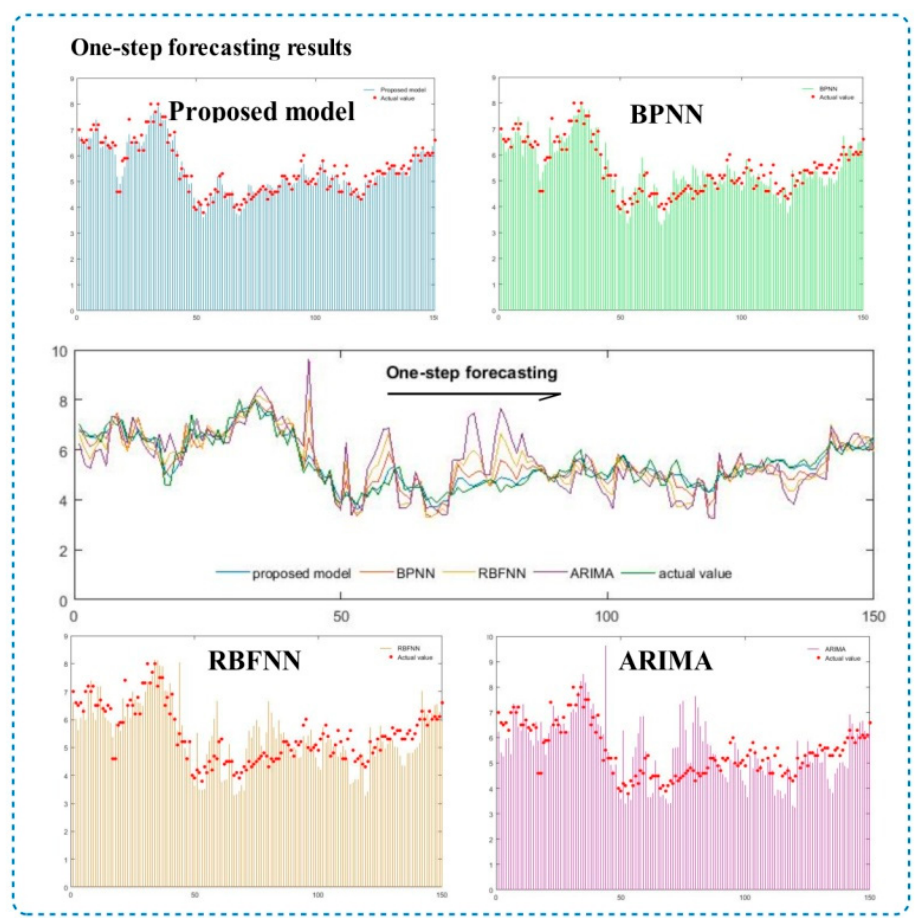
Figure 5. One-step forecasting results of the proposed model and other traditional models (BP RBF ARIMA).